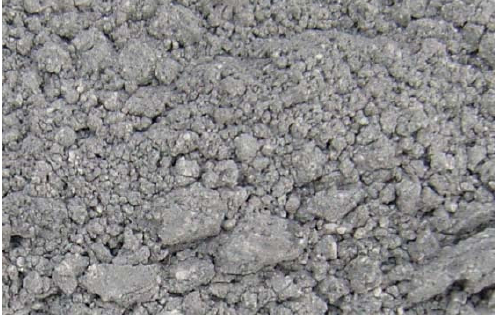
Figure 3. ZVM TPA powder used in the initial commercial trials (E145,